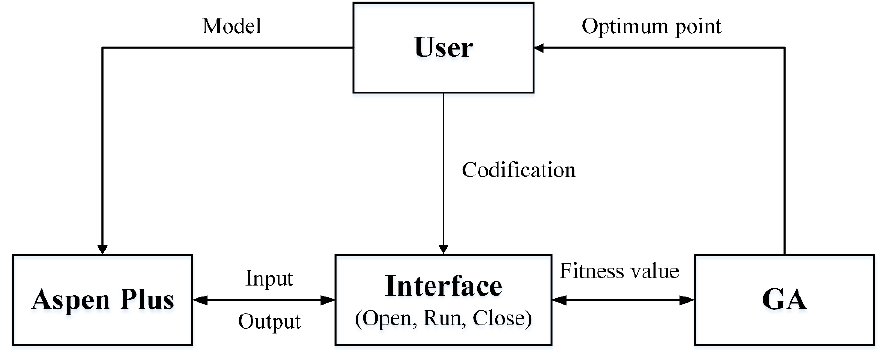
Figure 4. Interface diagram between Aspen and